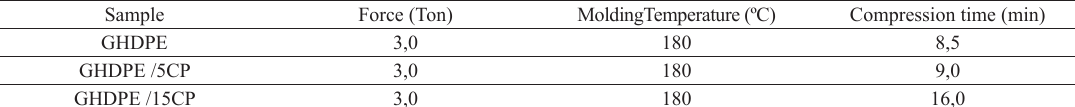
Table 3. Molding conditions of the ceiling lining plates used in the prototypes. Sample